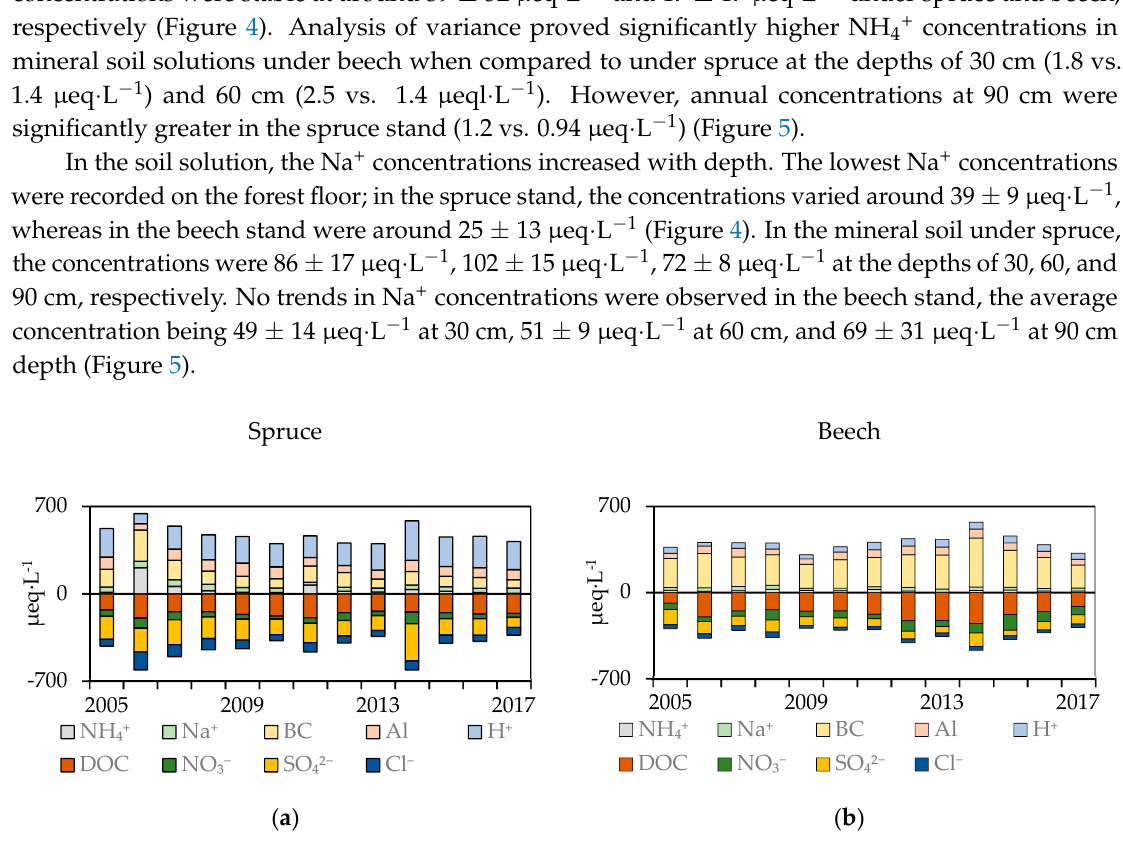
Figure 4. Soil solution concentrations from the forest floor in the spruce ( a ) and the beech ( b ) stand. DOC, NO 3 − , SO 4 2 − , and Cl − concentrations were reversed to show how reductions in acid anions were compensated by reductions of base cations, Al and H + .